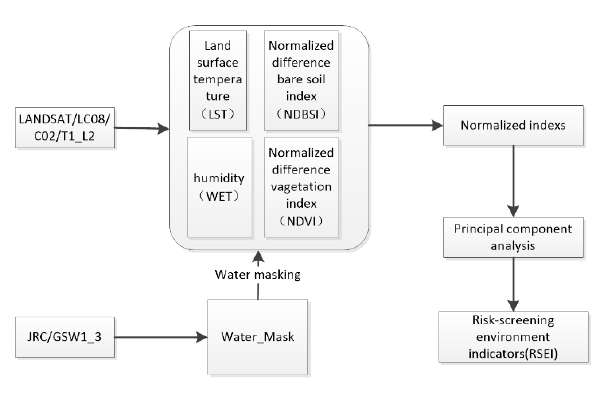
Figure 2. comprehensive risk assessment technology roadmap of Shanxi